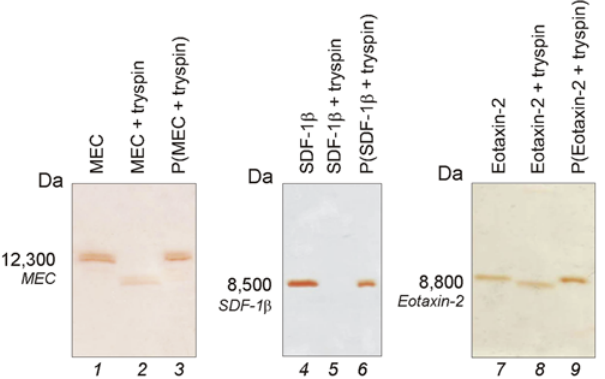
Figure 10. SDS PAGE analysis showing that core-shell particles protect chemokines from enzymatic degradation. Core-shell particles were incubated with the following chemokines, mucosae- associated epithelial chemokine (MEC/CCL28), stromal cell-derived factor-1 beta, (SDF-1 b /CXCL12b), and eotaxin-2 (CCL24), in presence of trypsin. Solution of the chemokines (control) are shown in Lanes 1, 4, and 7. Chemokines incubated with particles (Lane 3, 6, and 9) are protected from tryptic degradation whereas chemokines not incubated with particles (Lane 2, 5, and 8) are susceptible to proteolytic digestion.